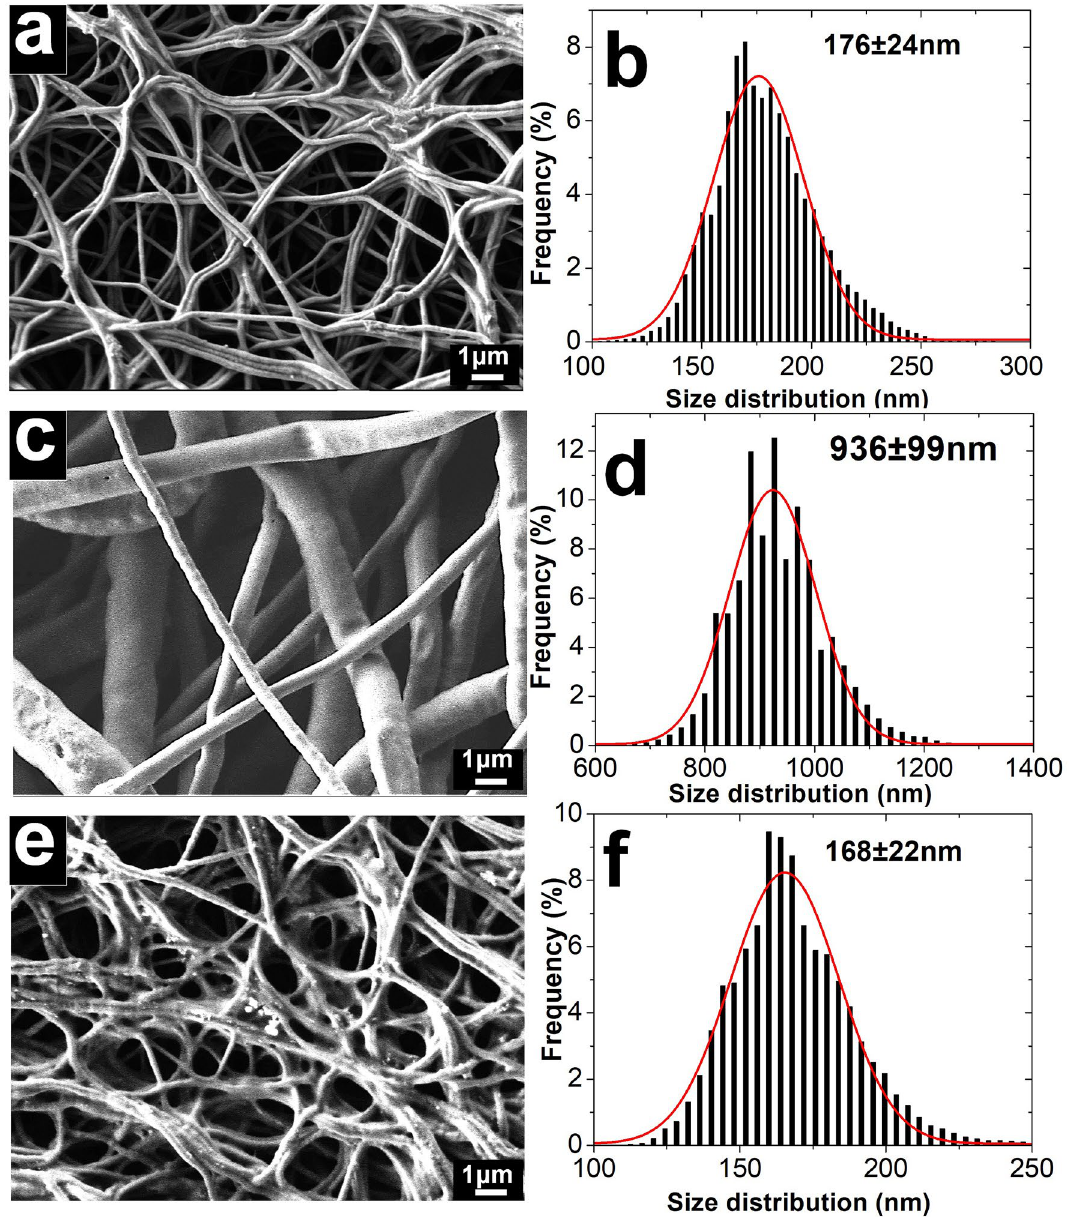
Figure 2. SEM micrographs and fiber size distribution of hybrid fiber (a,b) , PCL fiber (c,d) and core–shell fiber (e,f) . The result shows morphological and dimensional similarity of the core–shell fibers with the hybrid fibers